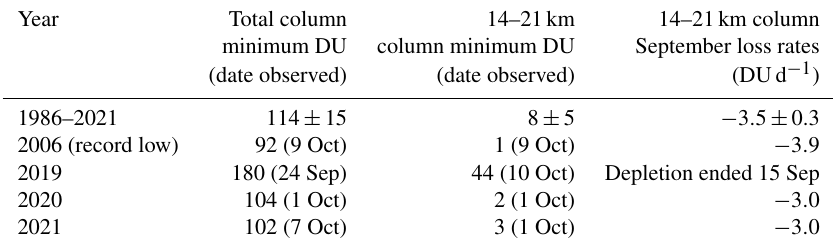
Table 3. The South Pole yearly ozone hole minimums in total column and 14–21km partial column ozone and the September loss rates during the long-term record (1986–2021) compared to the record low in 2006 and the extreme variability in the metrics in